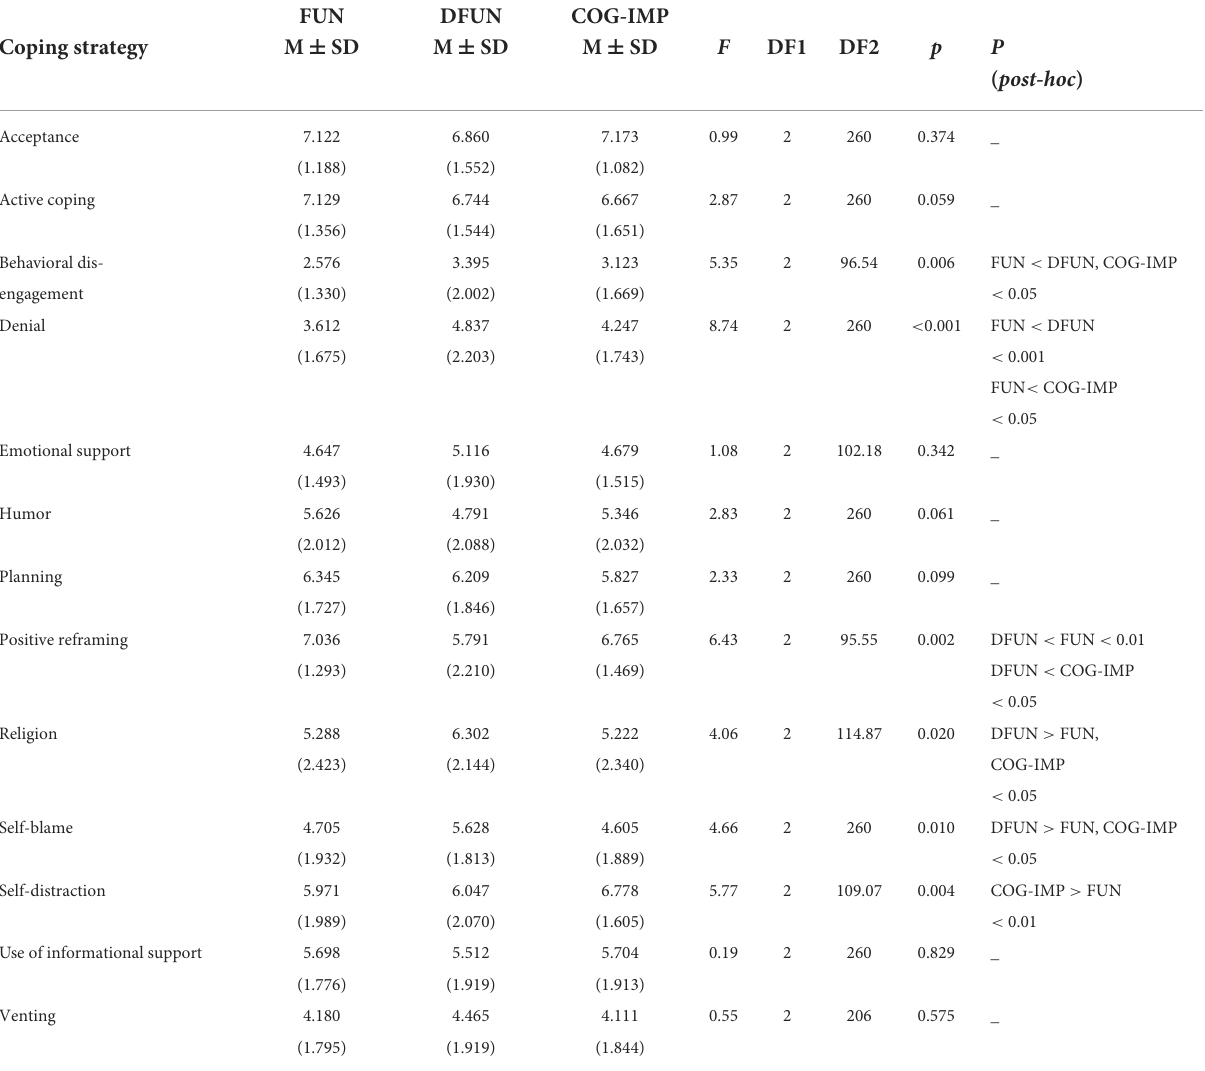
TABLE 5 Differences in coping strategies between patients in the clusters. FUN DFUN COG-IMP Coping